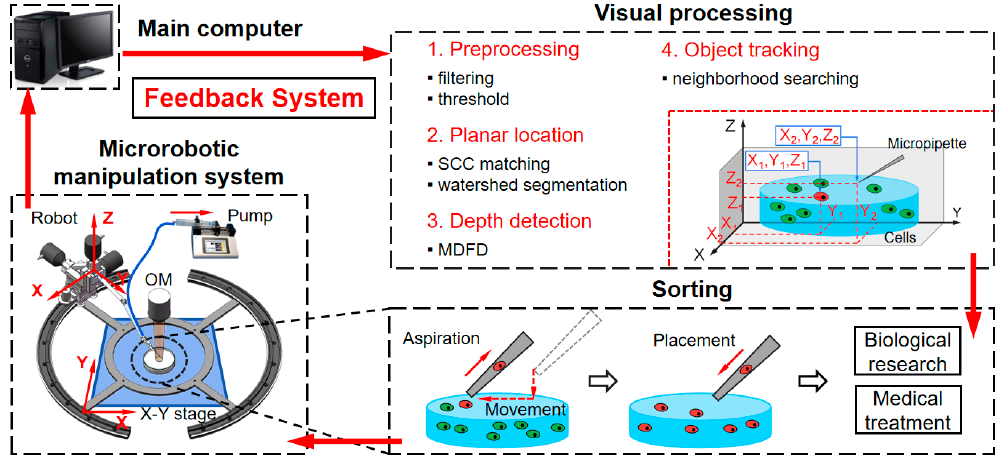
Figure 1. Schematic of automated sorting process.